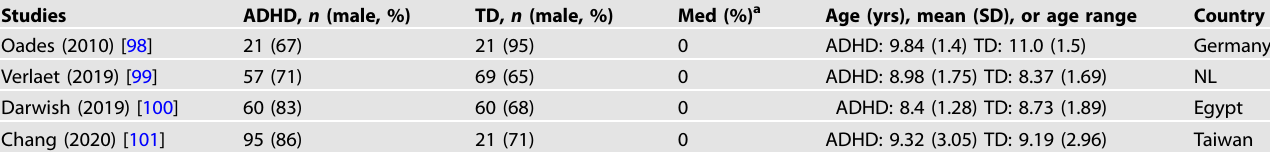
Table 2. Characteristics of Studies Included in the Meta-Analysis for In fl ammatory Biomarker Levels in Children with ADHD.